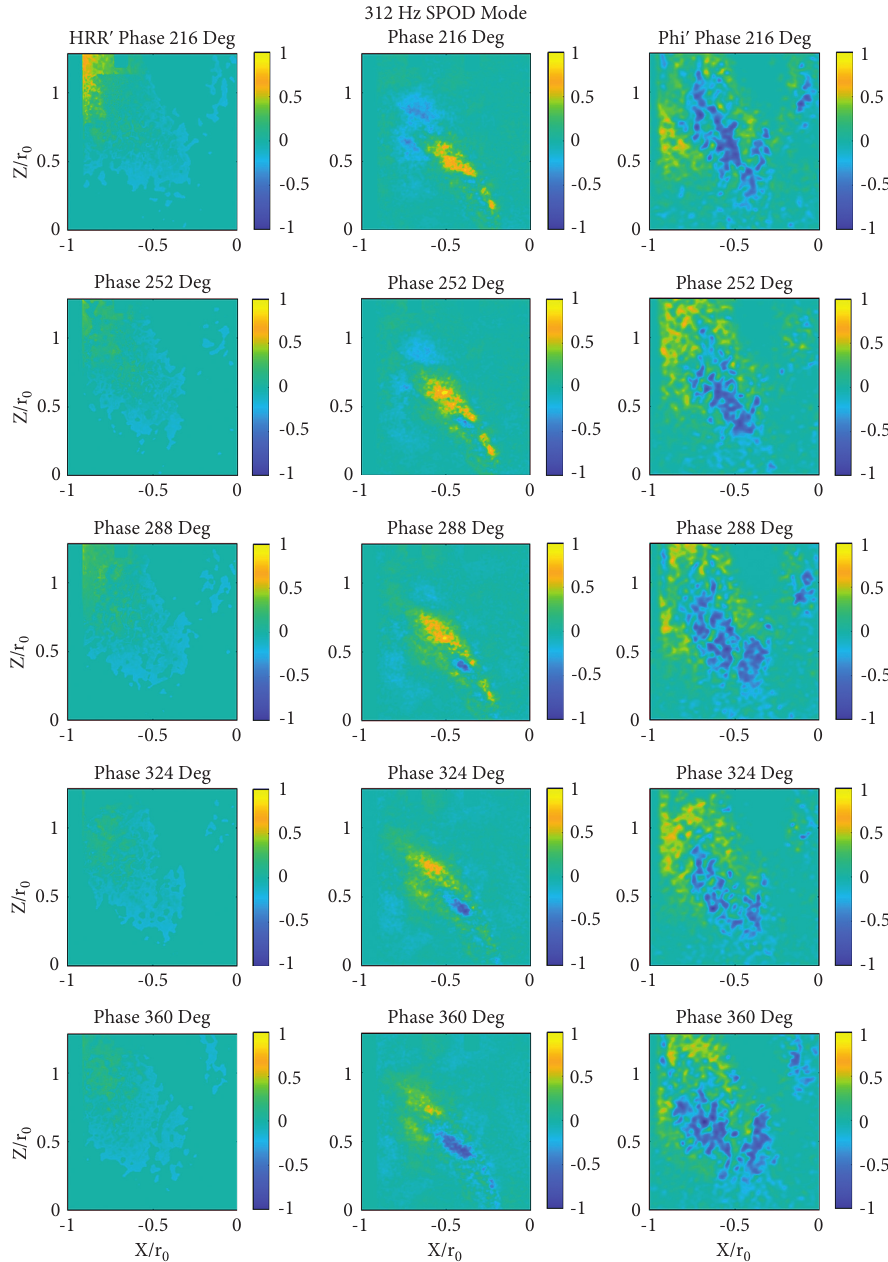
Figure 18: Comparison of phased averaged heat release fluctuations (HRR), SPOD mode at 312Hz, and phased averaged equivalence ratio fluctuations (Phi) for last five